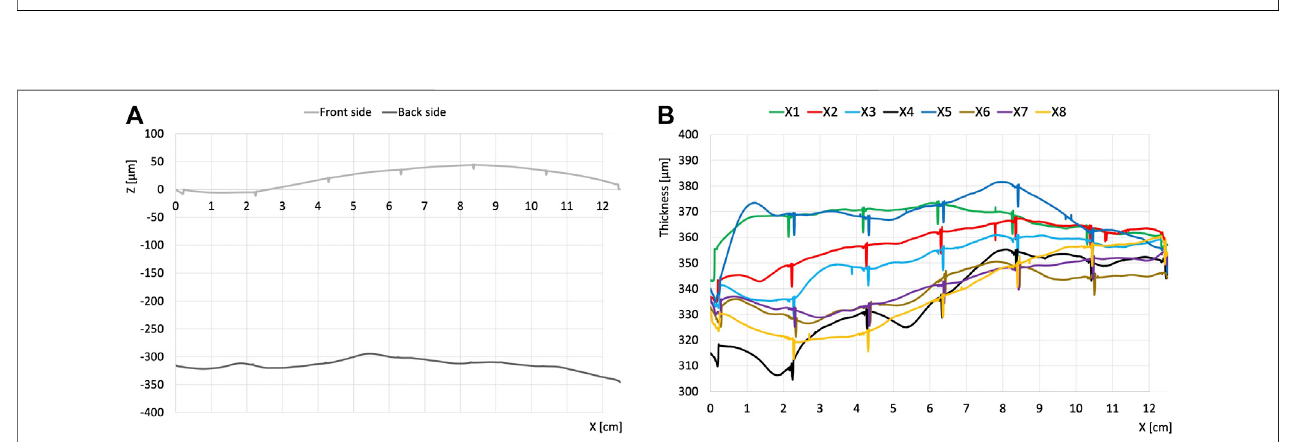
Frontiers in Physics |